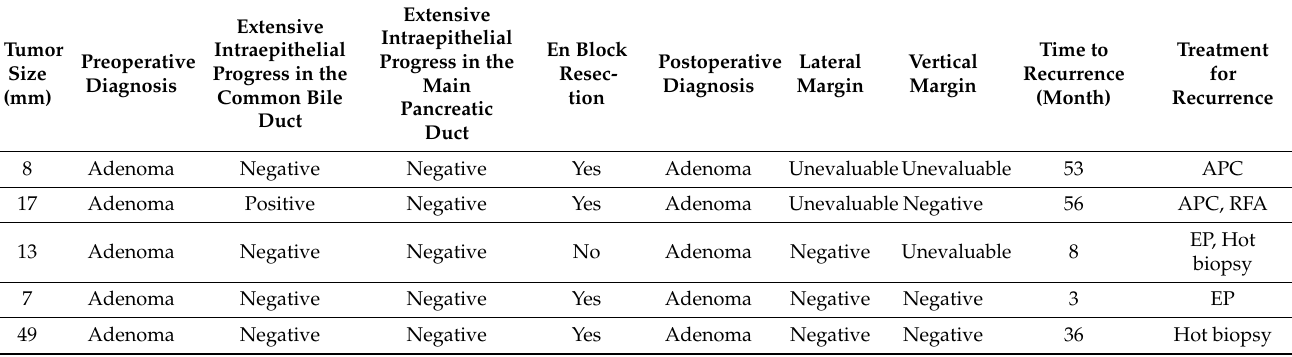
Table 3. Characteristics of patients who developed